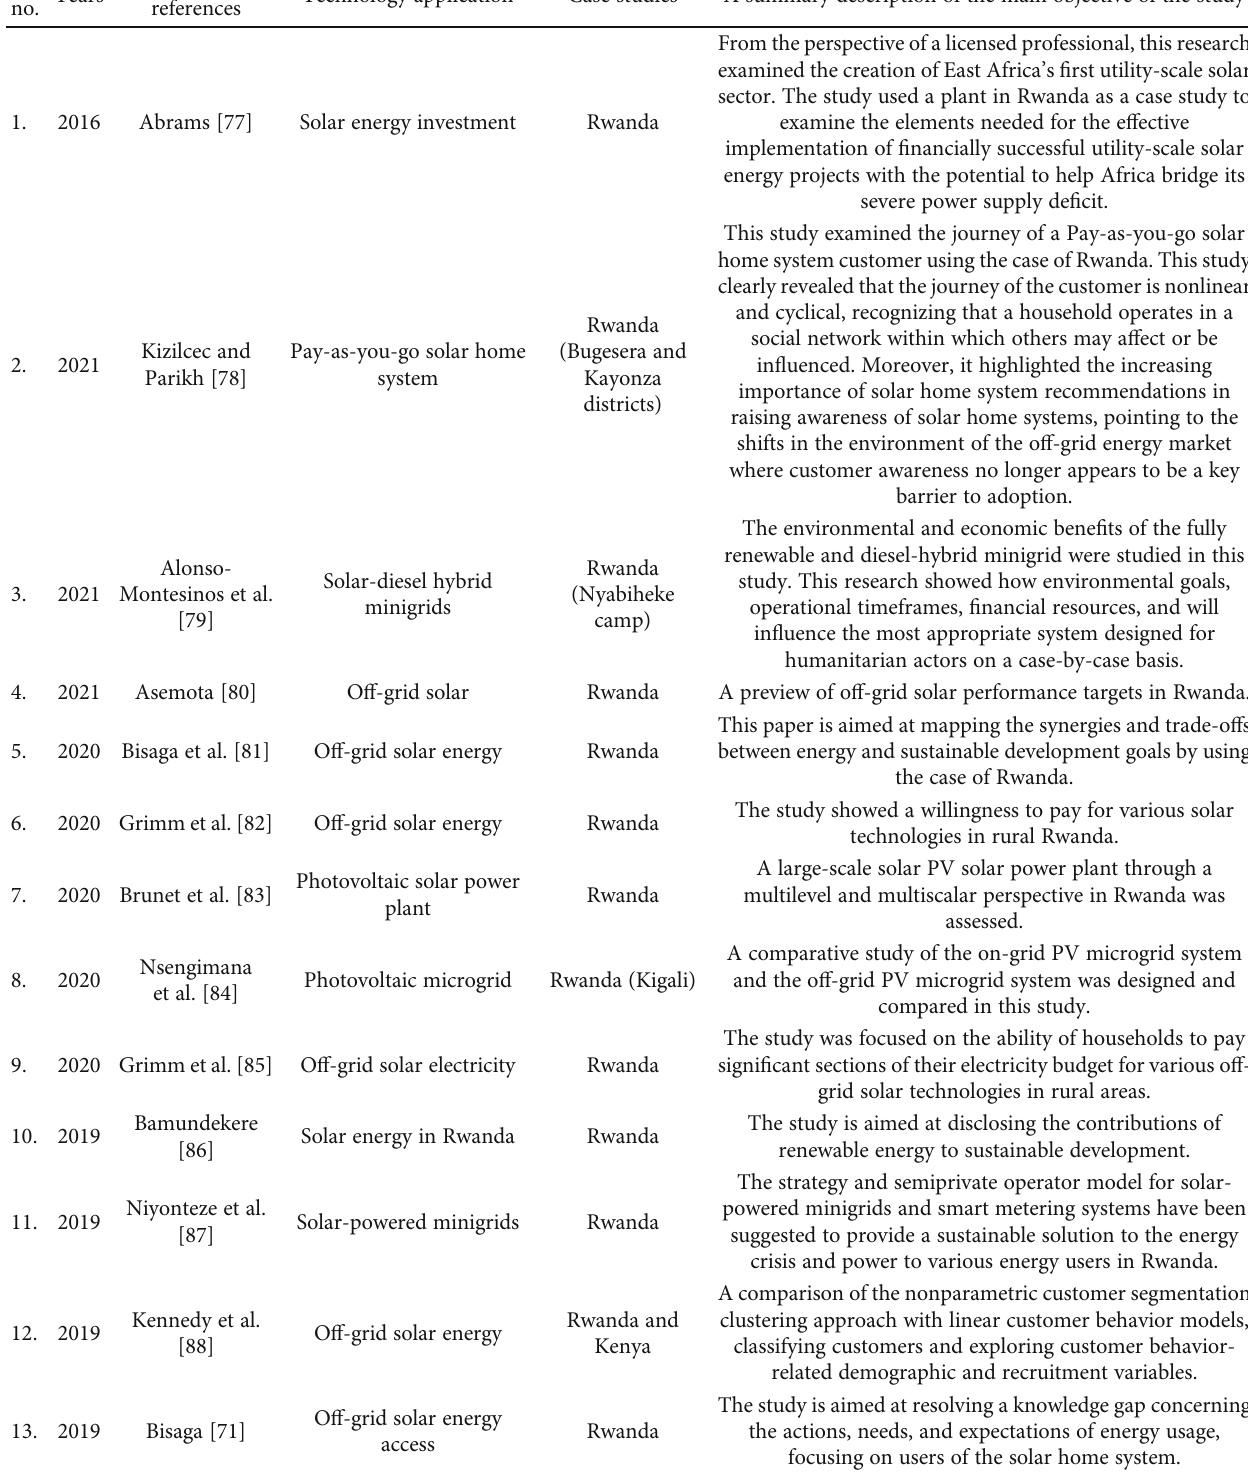
Table 4: Recent publications on solar energy in Rwanda in the last fi ve